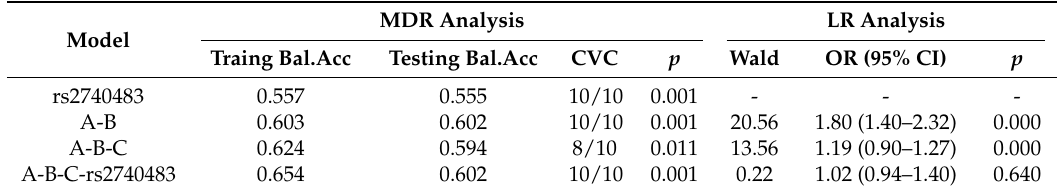
Table 6. Gene–gene interactions on the risk of